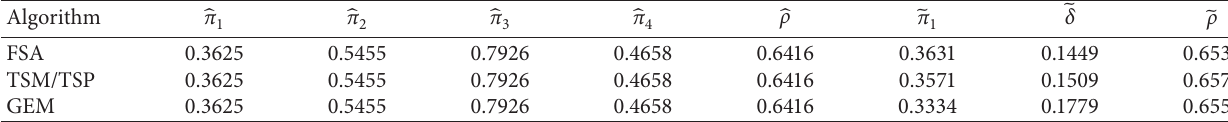
Table 12: Global and constrained MLEs.